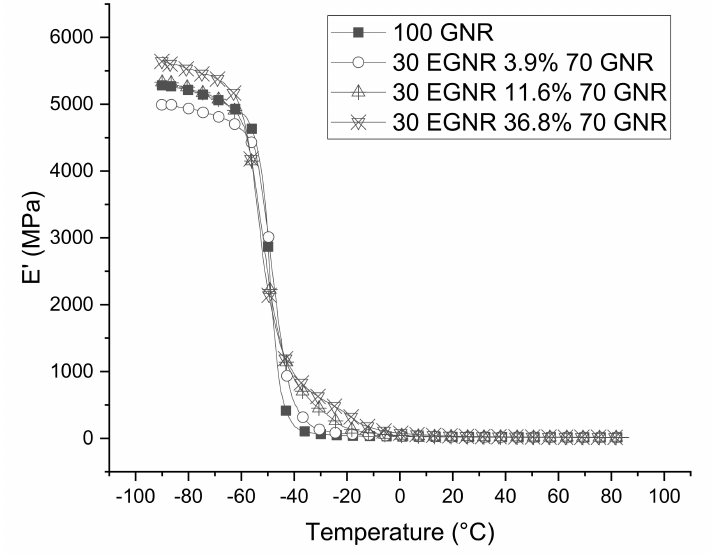
Figure 7. Elastic modulus (E’) of guayule natural rubber/epoxidized guayule natural rubber blend composites with various epoxide fractions. GNR 50CB: guayule natural rubber composites without epoxidation; 30EGNR 3.9% 70GNR 50CB: guayule natural rubber/epoxidized guayule natural rubber blend composites with 3.9% epoxide fraction; 30EGNR 11.6% 70GNR 50CB: guayule natural rubber/epoxidized guayule natural rubber blend composites with 11.6% epoxide fraction; 30EGNR 36.8% 70GNR 50CB: guayule natural rubber/epoxidized guayule natural rubber blend composites with 36.8% epoxide